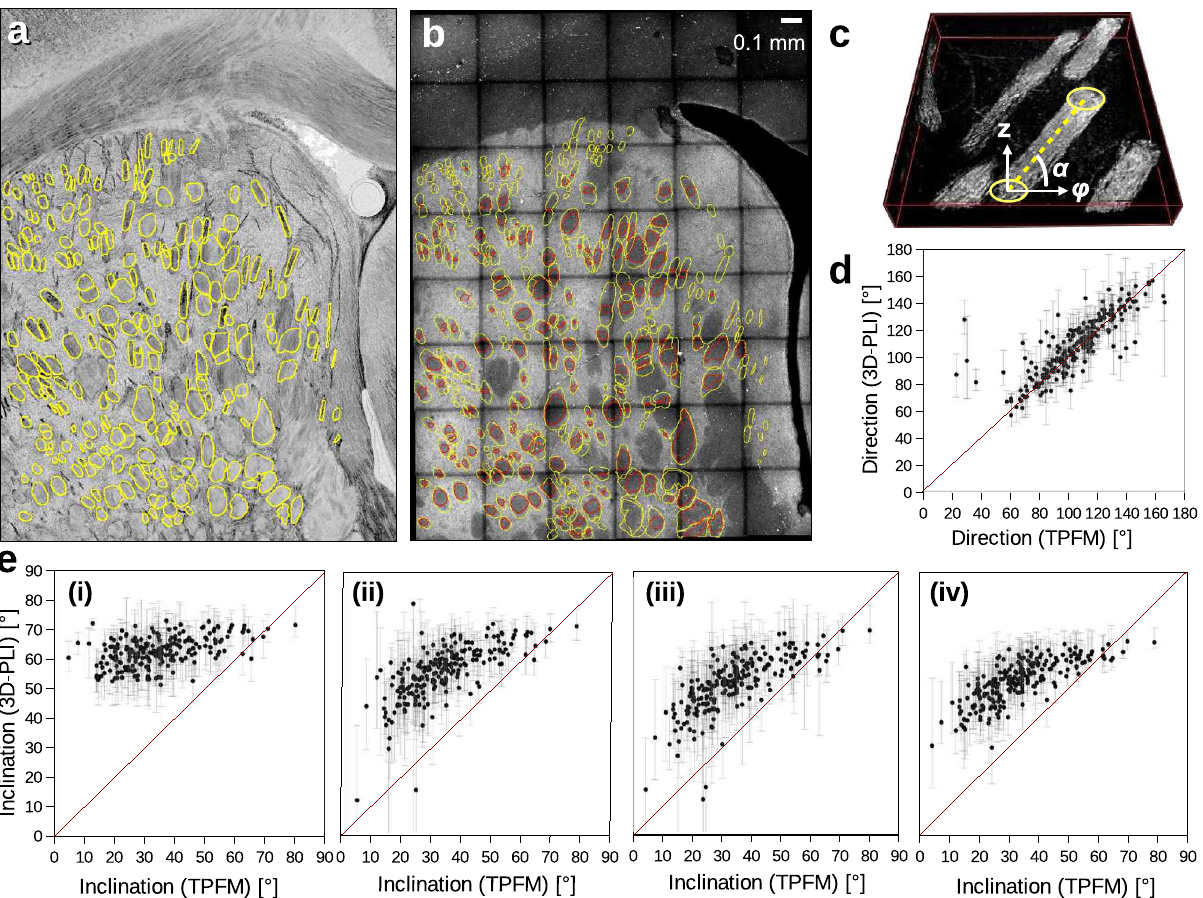
Figure 6. Comparison of 3D-PLI and TPFM nerve fibre orientations for a coronal rat brain section (230 selected fibre bundles in the caudate putamen). ( a ) Inclination map obtained from the 3D-PLI measurement (using Eq. 8). The fibre bundles selected for evaluation are labelled by yellow lines. ( b ) Maximum intensity projection of the TPFM image stack (containing 6 × 8 tiles). The yellow contours show the first and the last fully visible cross-sections of the fibre bundles in the TPFM image stack which were used to geometrically reconstruct the fibre inclinations. The red shapes denote the overlap of the cross-sections. Only fiber bundles with defined orientation (not crossing or bending fibers) were selected for evaluation. ( c ) 3D-model of the TPFM image stack showing only fibrous tissue (1 tile, adapted from Menzel et al. 19 , Fig. S2c). The three- dimensional fibre orientation (dashed yellow line, defined by the in-plane direction angle ϕ and the out-of- plane inclination angle α ) was geometrically computed from the centres of gravity of the bundle cross-sections mentioned above (yellow shapes). ( d ) Direction angles of the fibre bundles derived from the aligned 3D-PLI and TPFM measurements. The grey bars denote the positive and negative standard deviation when averaging the pixel values over the selected regions in the 3D-PLI direction image. ( e ) Inclination angles of the fibre bundles derived from the aligned 3D-PLI and TPFM measurements. The 3D-PLI inclinations were computed for four different scenarios (cf. Fig. 5): ( i ) unweighted model ( α LM ) applied to whole brain section, ( ii ) transmittance- weighted model ( α HM ) applied to whole brain section, ( iii ) unweighted and transmittance-weighted models applied to LM- and HM-regions individually, ( iv ) unweighted and transmittance-weighted models applied to LM- and HM-regions using a linear combination of both formulas in the transition